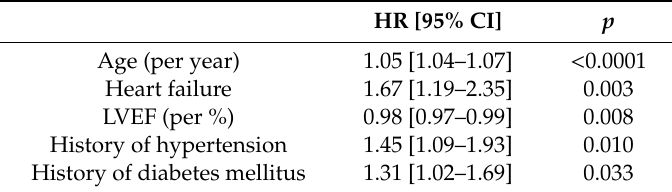
HR, hazard ratio; CI, confidence interval; LVEF, left ventricular ejection fraction. The variables included in the model were age, sex, history of hypertension, history of diabetes mellitus, previous myocardial infarction,